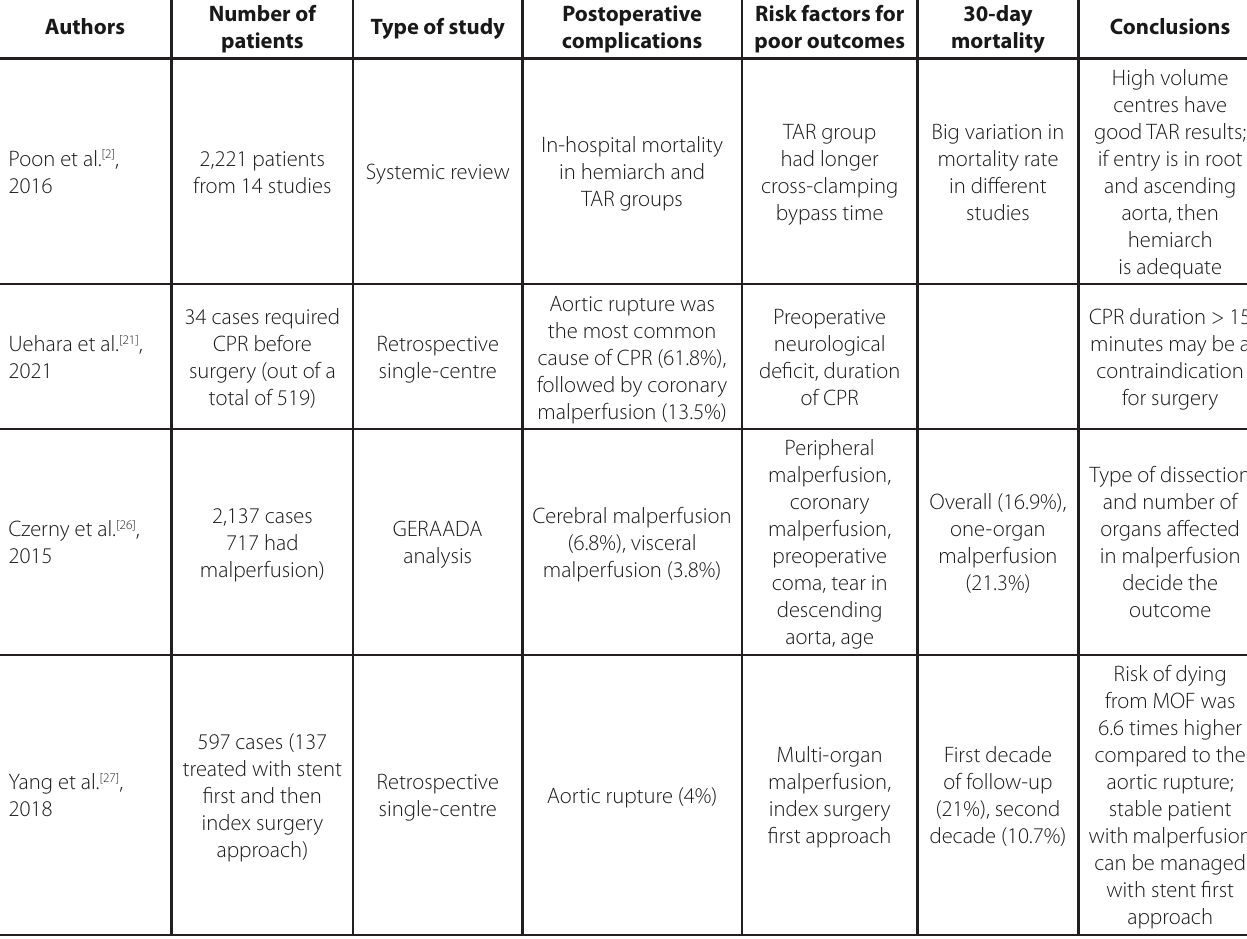
Table 2. Summary of contemporary literature in TAAD